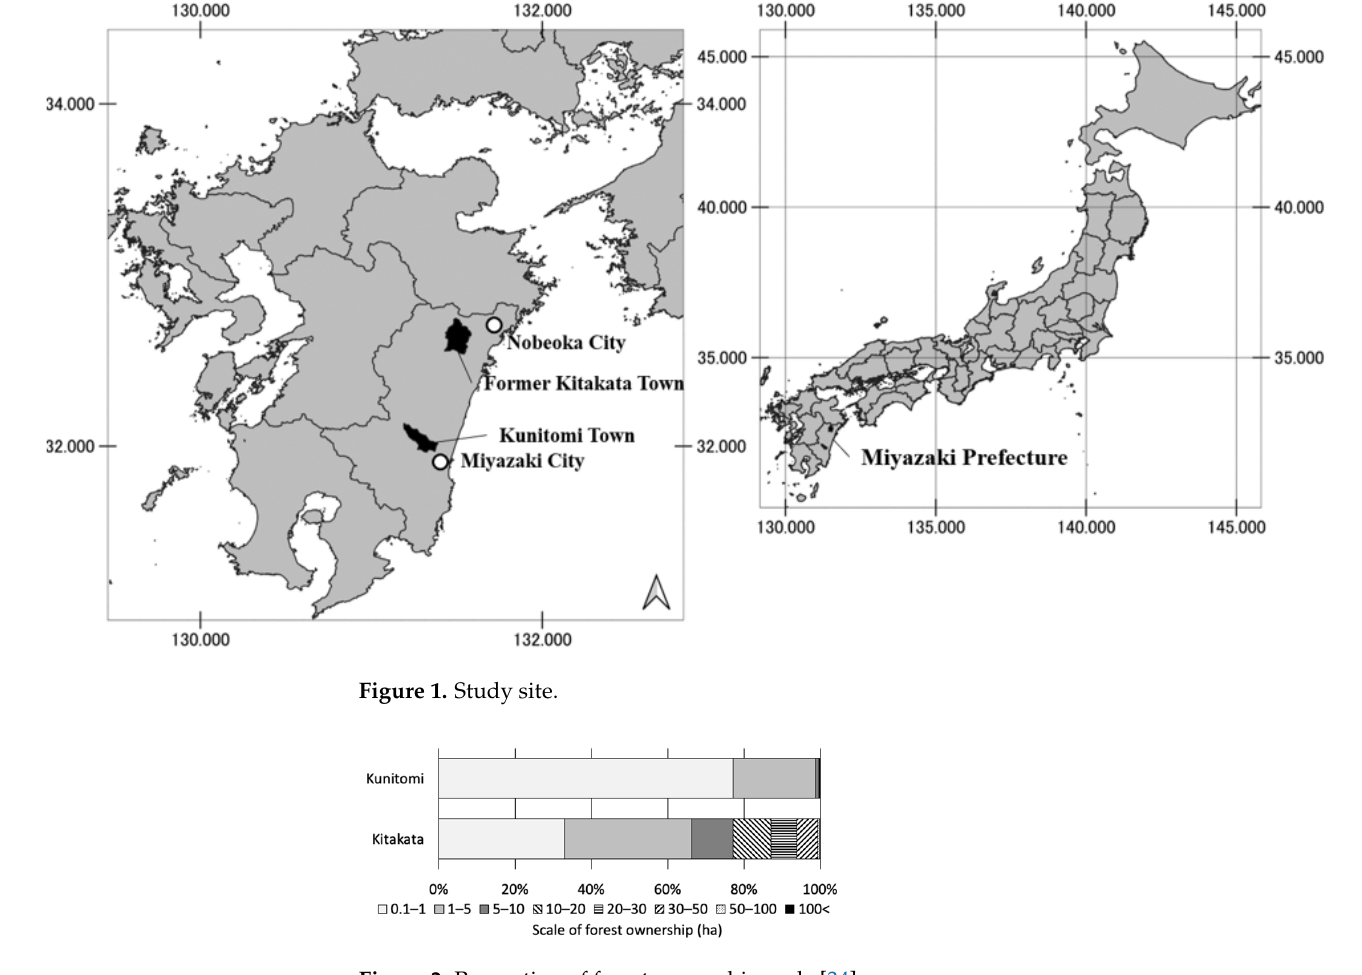
Figure 2. Proportion of forest ownership scale [34].